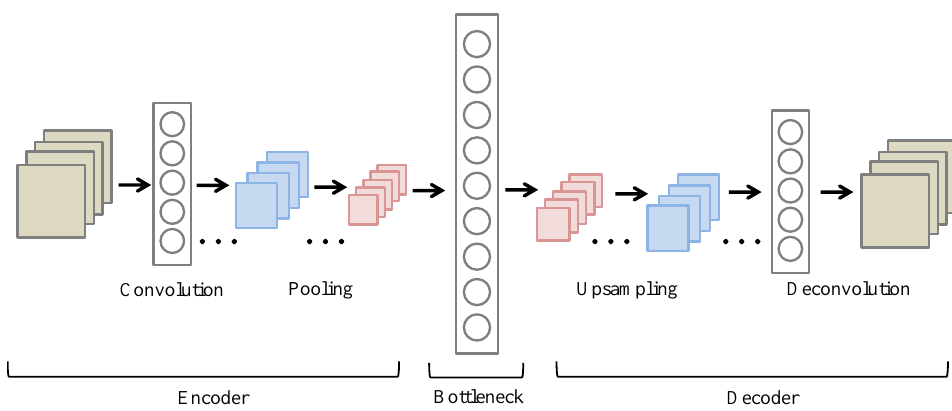
Figure 2. The architecture of the CAE model.